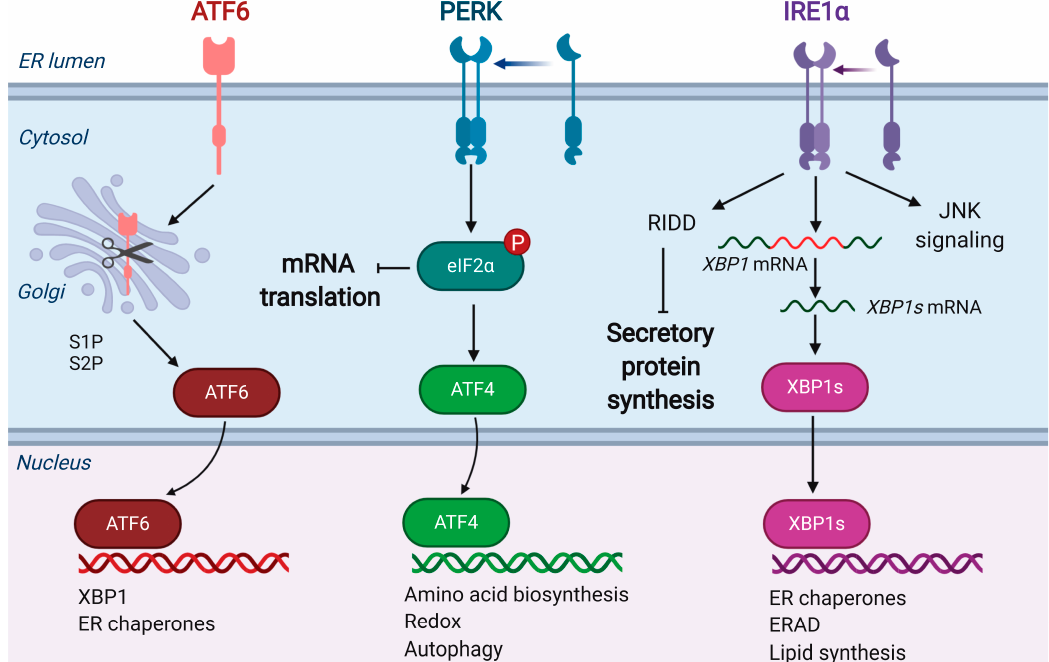
Figure 2. Regulation of ER Stress by the Unfolded Protein Response and E ff ects on Cardiokine Secretion. Perturbations of the ER environment result in the activation of the unfolded protein response, mediated by ER-resident integral membrane proteins ATF6 (activating transcription factor 6), PERK (protein kinase RNA (PKR)-like ER kinase), and IRE1 α (inositol requiring enzyme 1 α ). Upon ER stress, ATF6 translocates to the Golgi apparatus, where it is cleaved by site-1 and site-2 proteases (S1P, S2P), liberating an N-terminal fragment to translocate to the nucleus, where it is a potent and labile transcription factor that activates the transcription of ER chaperones and the transcription factor X-box binding protein 1 (XBP1). Activation of ATF6 may increase ER secretory capacity [35]. PERK dimerization activates autophosphorylation of its kinase domain, leading to phosphorylation of the α -subunit of translation initiation factor 2 (eIF2 α ) at Ser51. This inhibits global translational initiation, including translation of mRNAs encoding secretory proteins, reducing the load of unfolded proteins entering the ER. PERK activation also results in the induction of translation of selective mRNAs, including activating transcription factor 4 (ATF4), which activates the transcription of a wide range of genes involved in adaptation to stress conditions. Upon activation, IRE1 α oligomerizes and carries out regulated IRE1-dependent decay (RIDD) of ER-targeted transcripts, as well as unconventional RNA splicing, by removing an intron from the XBP1 mRNA, allowing it to become translated into the functional transcription factor, XBP1s. XBP1s activates the transcription of ER chaperones, endoplasmic reticulum associated degradation (ERAD) genes, and genes involved in lipid